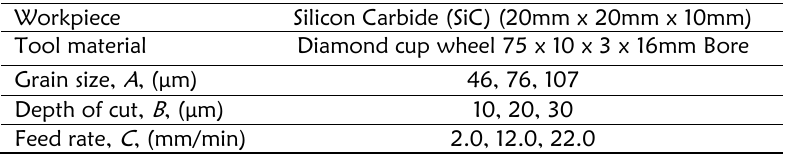
Table 1: Experimental condition and variables